Question: Condense the content of this figure into a single sentence.
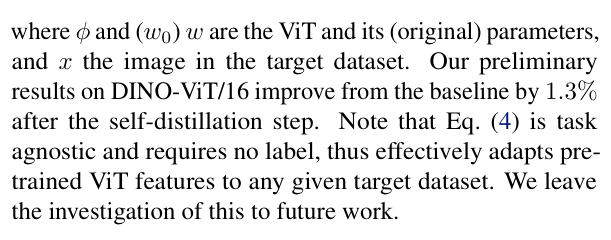
Answer: Relative improvement on DAVIS-2017 dataset vs dif- ferent noise levels. There exists an inherent trade-off between perturbation level and performance gain. Smaller perturbation ranges result in weaker improvements from the baseline model due to lower input diversity, while larger perturbations are susceptible to greater information loss. 3 pixels is found to be the optimal perturbation level on both ViT-S/16 and Vit-B/16.